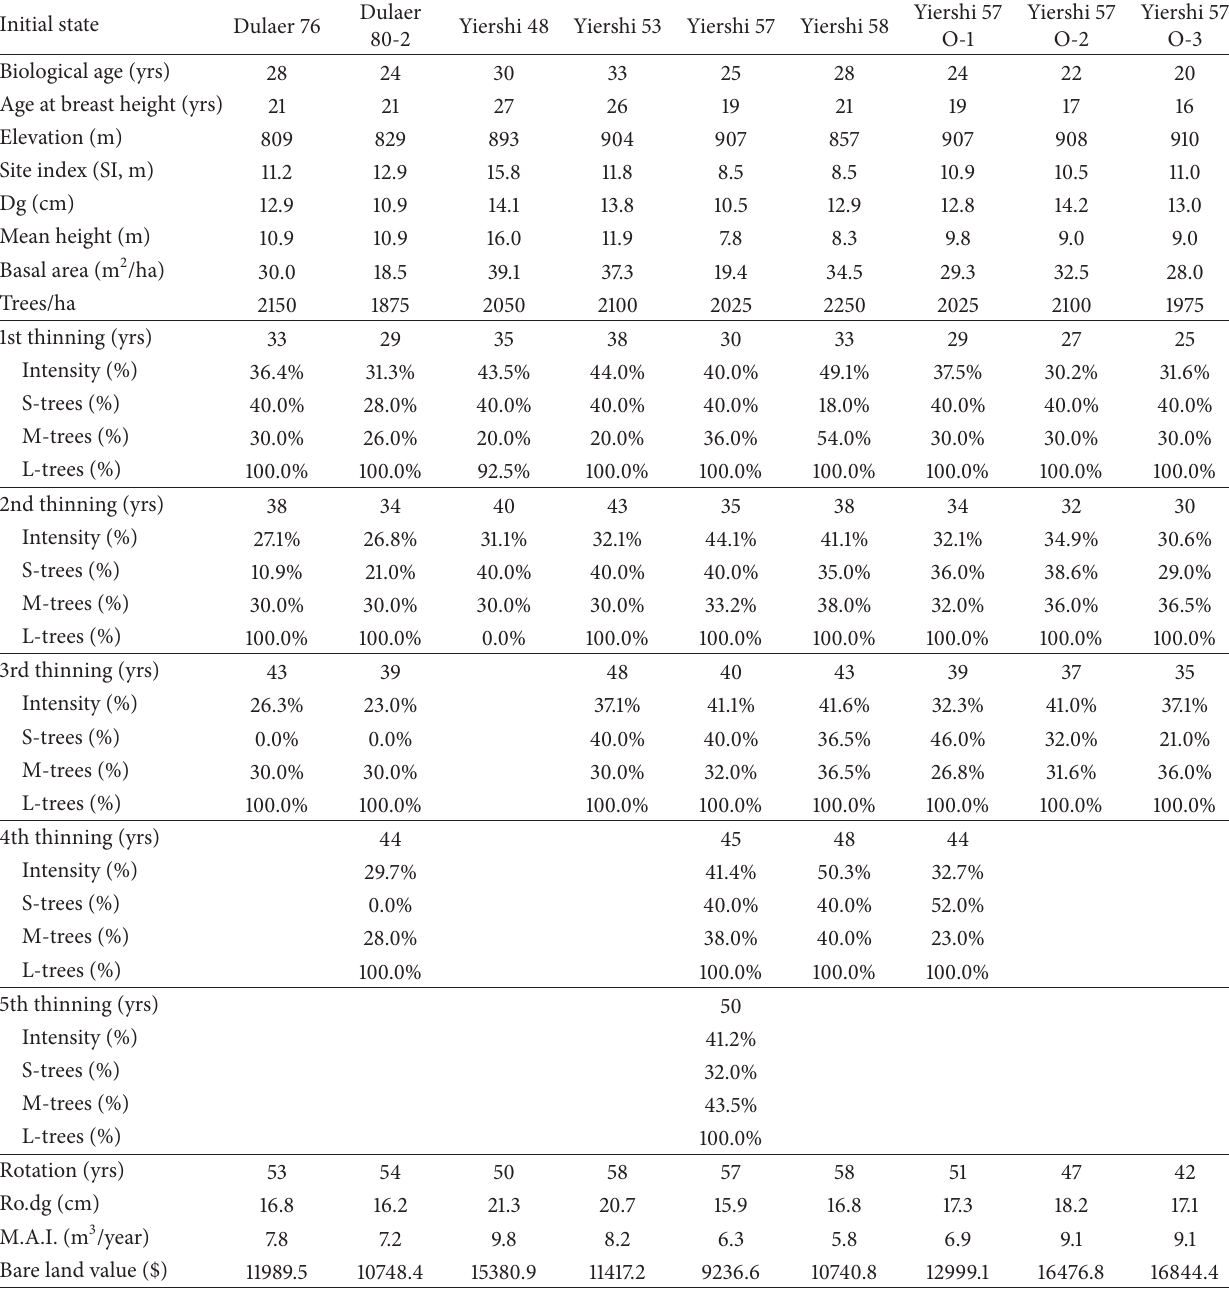
Table 1: Deterministic optimal solution with 3.5% interest